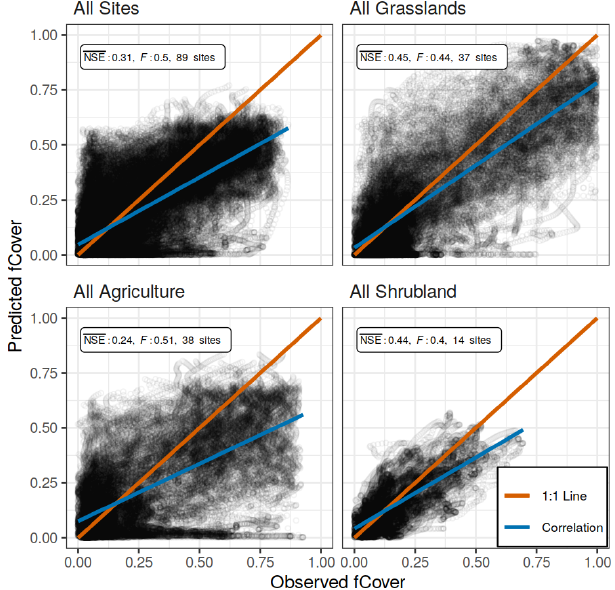
Figure 3. Observed and predicted daily fCover values of the all site model and the three vegetation type models, each using all available sites and years with the respective spatial scale. NSE is the average Nash–Sutcliffe coefficient of efficiency among sites, and F is the mean coefficient of variation of the mean absolute error. The cor- relation line (blue) represents the overall trend in predicted versus observed values, while the 1 : 1 line (red) represents a perfect